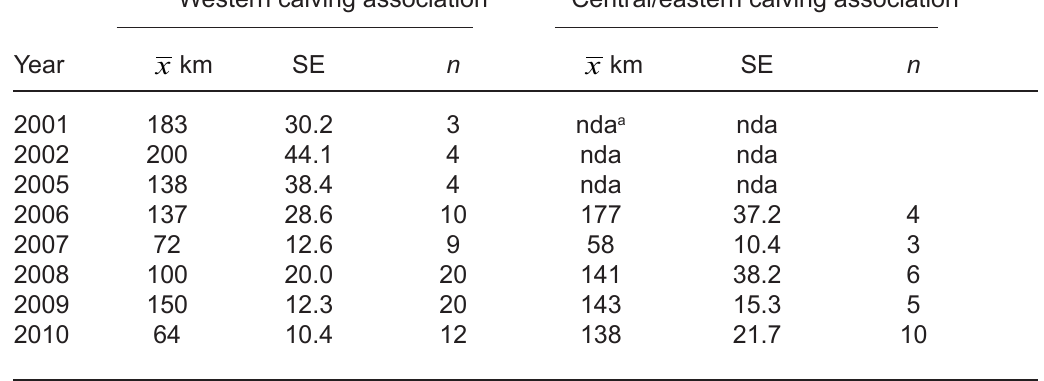
Table 6. Mean distances (standard deviation) between individual rut locations and centroids for western and central/ eastern calving